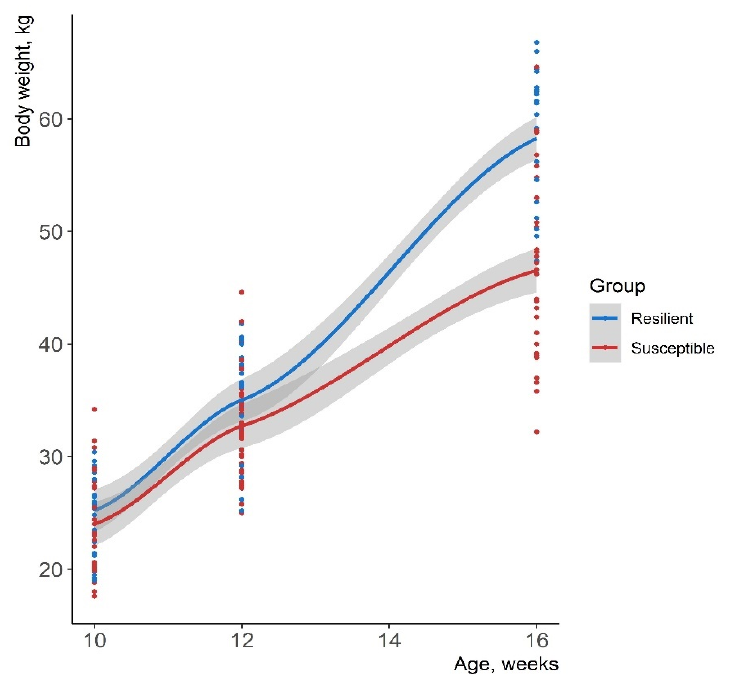
Figure 4. Growth curves of pigs from the resilient and susceptible groups. The grey band represents the confidence interval. Individuals were colored according to their group classification using the criterion from Figure 2.